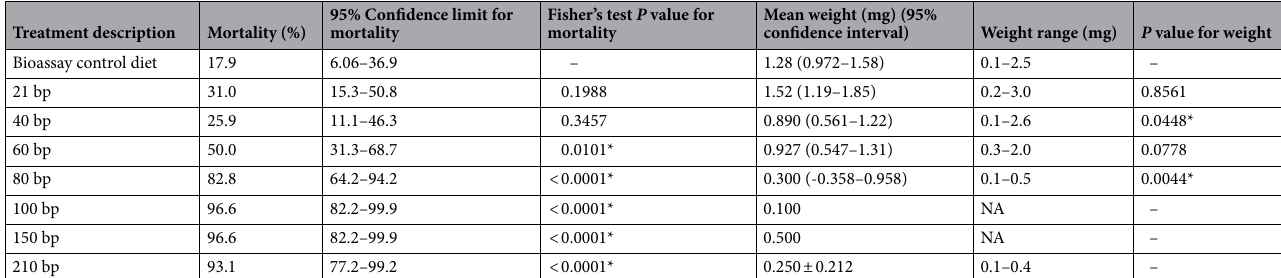
Table 2. Analysis of WCR mortality fed various lengths of DvSSJ1 dsRNA. A series of seven different lengths of DvSSJ1 dsRNA was incorporated into a standard artificial diet and WCR mortality was recorded as described in Method. *A statistically significant difference ( P value < 0.05) was